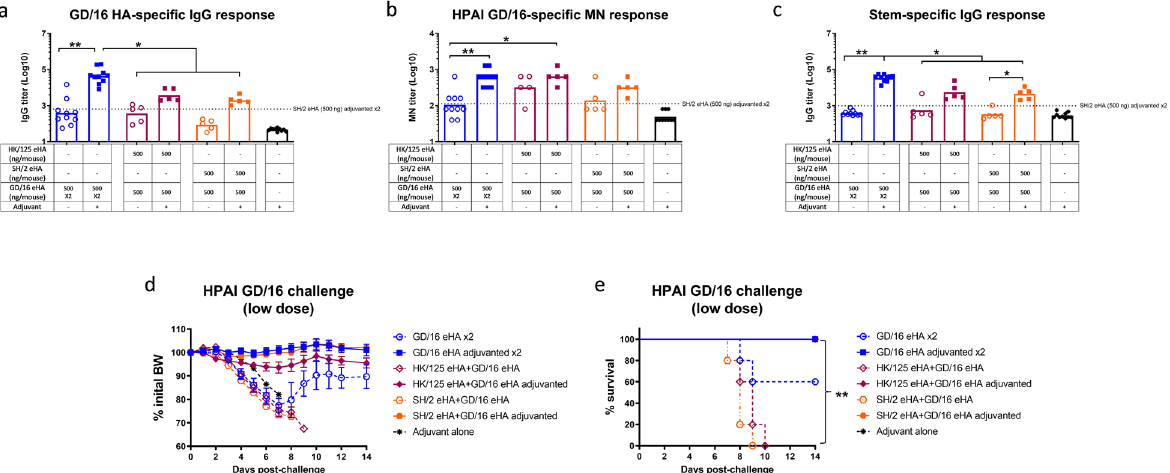
Fig. 5 Immunogenicity and protection of heterologous prime-boost immunization against highly pathogenic avian in fl uenza H7N9 challenge. BALB/c mice were primed with HA extracted (eHA) from H7N9 candidate vaccine viruses A/Shanghai/2/2013 (SH/2) or A/Hong Kong/125/2017 (HK/125) and boosted with A/Guangdong/17SF003/2016 (GD/16) with or without adjuvant. Immunized mice were challenged with highly pathogenic avian in fl uenza (HPAI) wild type (wt) GD/16 virus at 5 × 10 4 TCID 50 /50 µl/mouse (low dose) in a BSL-3 + biocontainment. ( a ) IgG ELISA titers against GD/16 HA; ( b ) microneutralization (MN) titers against HPAI wt GD/16 virus; ( c ) HA group 2 stem- speci fi c IgG ELISA titers; ( d ) Body Weight (BW) and ( e ) survival after HPAI wt GD/16 challenge. Individual titers with geometric mean (bars) are shown ( n = 5 – 10 mice/group). * p < 0.05 and ** p < 0.01 by Kruskal – Wallis test with Dunn ’ s multiple comparisons after log transformation (antibody responses) or by Log-rank (Mantel – Cox) test (survival